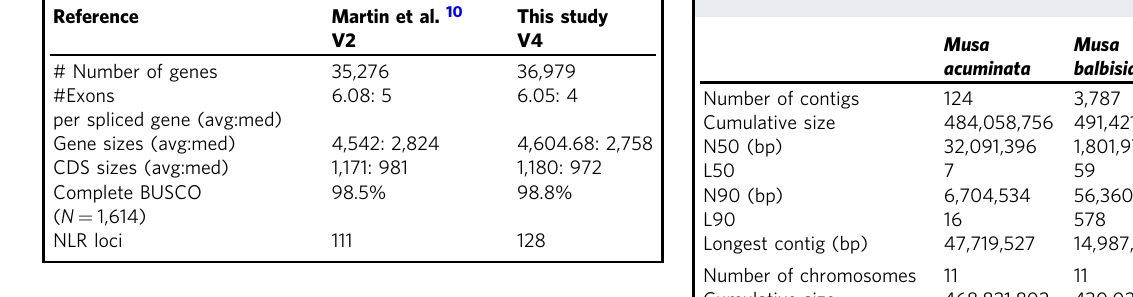
Table 2 Comparison of gene prediction statistics. Table 3 Comparison of A ( Musa acuminata ), B ( Musa balbisiana ) and S ( Musa schizocarpa ) genomes